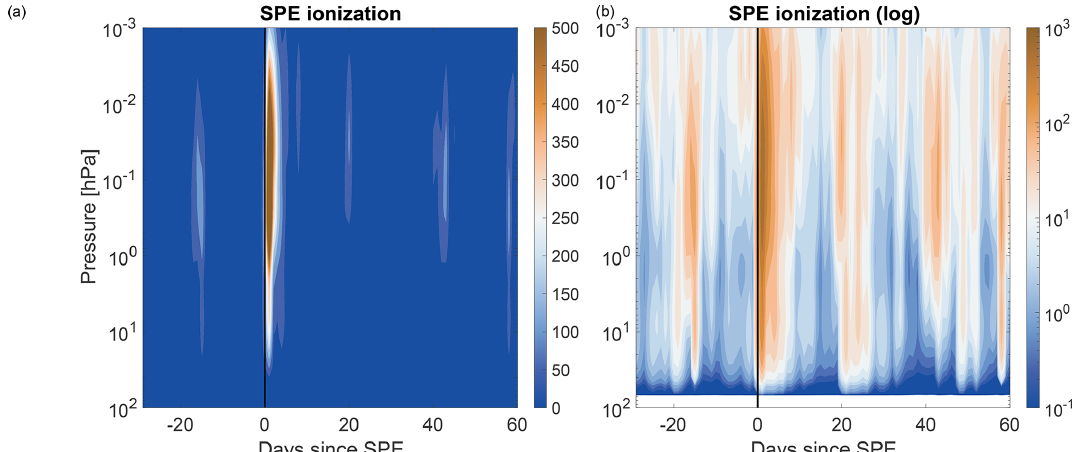
Figure 3. Composite mean of epoch time series of SPE ionization rates in linear (a) and logarithmic (b) color scale. The x axis shows the number of days before and after the event (day 0, solid black line) and the y axis pressure levels in the